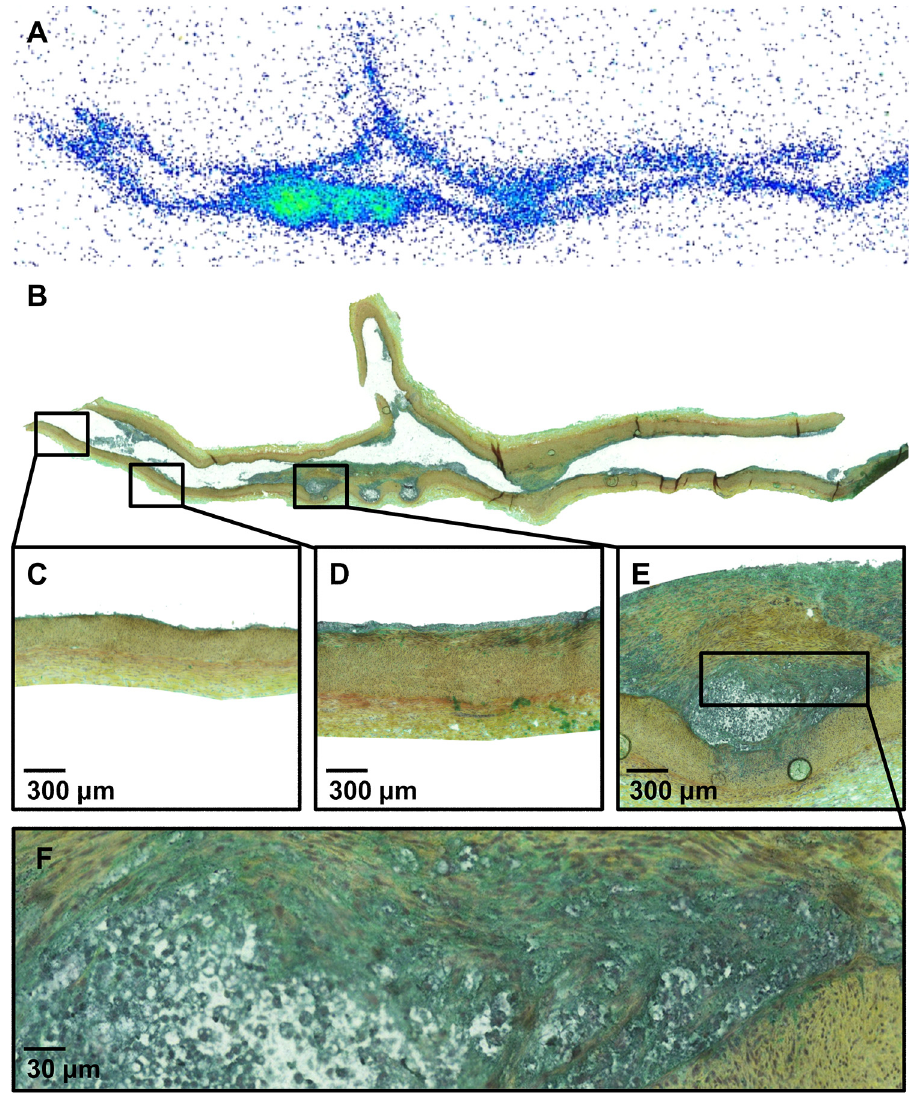
Fig 2. Representative [ 18 F]FDG autoradiograph (A) and a serial tissue section stained with Movat pentachrome (B). The inserts show areas of normal vessel wall (C), intimal thickening (D) and atheroma (E) at higher magnification. Panel F shows lipid core surrounded by densely cellular tissue at high